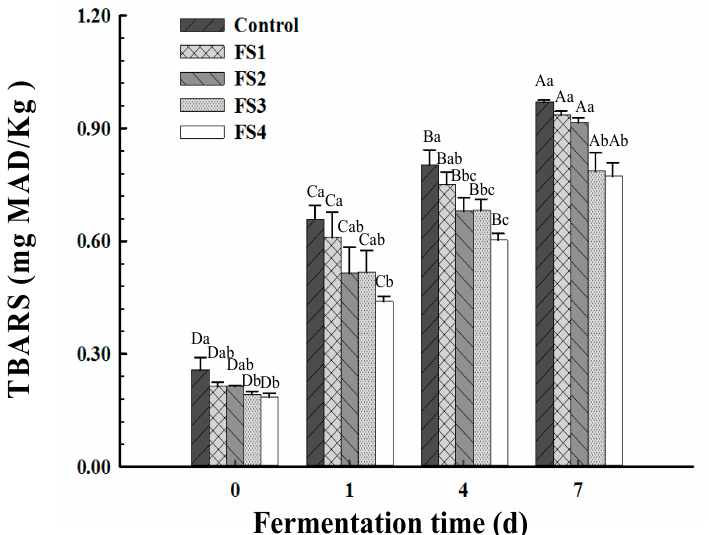
Figure 2. Changes in thiobarbituric acid reactive substance (TBARS) values of Harbin dry sausages with different replacement levels of CFS during fermentation. Control: 100% backfat; FS1: 80% backfat and 20% CFS; FS2: 60% backfat and 40% CFS; FS3: 40% backfat and 60% CFS; FS4: 20% backfat and 80% CFS. Different lowercase letters (a–c) mean significant differences among the treatments ( p < 0.05). Different uppercase letters (A–D) mean significant differences among different fermentation times ( p < 0.05). Table 4. Changes in colour values ( L* , a* and b* ) of Harbin dry sausages with different replacement levels of CFS during